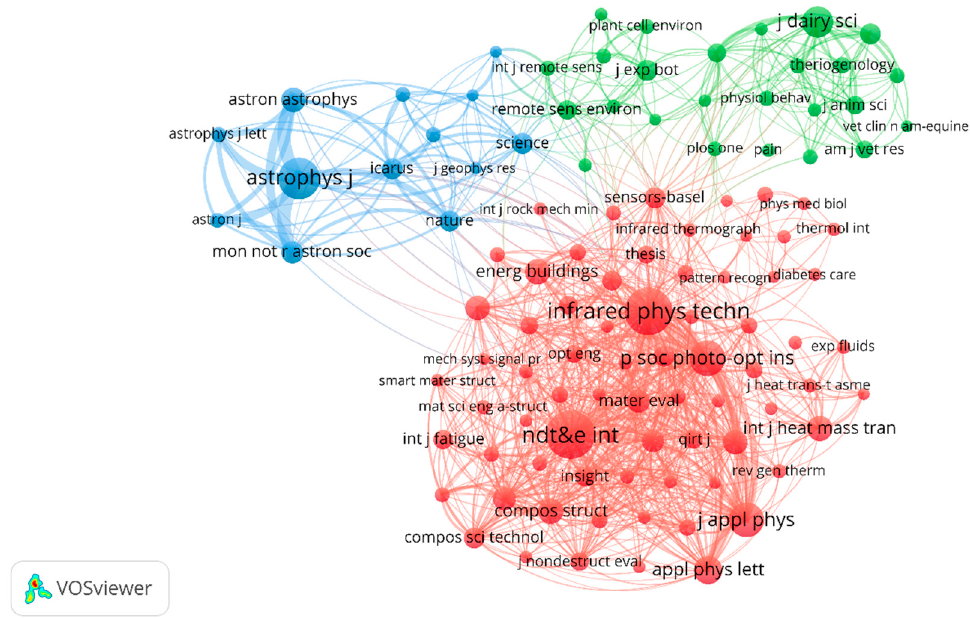
Figure 5. Publication cocitation knowledge map.